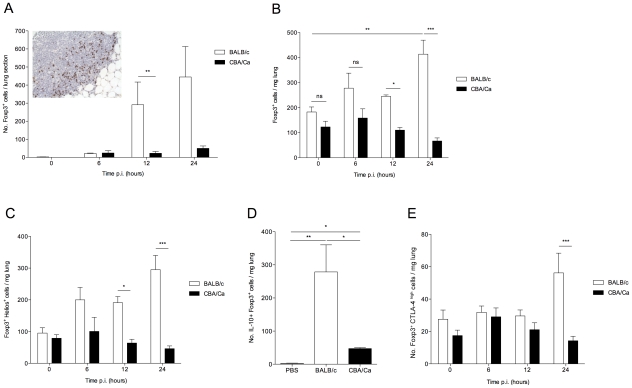
IL-10-producing natural T regulatory cells are rapidly recruited to the lung in S. pneumoniae-infected BALB/c mice.All results are from intranasal-infection of mice with wild-type S. pneumoniae D39. (A) Foxp3 immunostaining of lung sections taken from BALB/c and CBA/Ca mice during pneumococcal infection. Inset shows example staining from 12 hour p.i. BALB/c mouse. Foxp3+ cells stain brown. (B) Number of Foxp3+ T regulatory cells, (C) Number of Foxp3+Helios+ cells, (D) number of Foxp3+IL-10+ cells and (E) number of Foxp3+CTLA-4+ cells per mg lung in S. pneumoniae-infected BALB/c and CBA/Ca mice, as identified by flow cytometry. Data in (D) are from 24 hrs p.i., PBS group contains both BALB/c and CBA/Ca mice. White bars=BALB/c, black bars=CBA/Ca. *'s indicate significant difference, where *=p<0.05, **=p<0.01, and ***=p<0.005. For all graphs data represent mean +/− SEM. All results are representative of between 2–4 independent experiments with >4 mice per group.